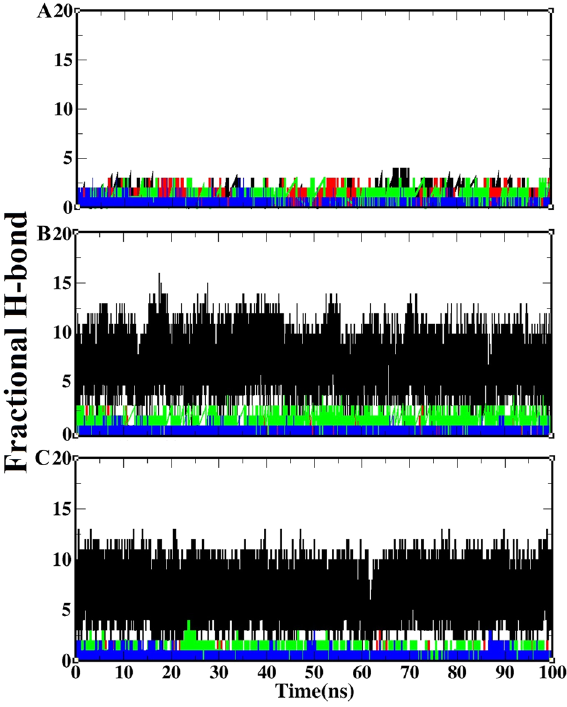
Figure 2. The fractional H-bonds of the receptor-spike protein complex during the simulation: hydrogen bonds between four regions of the ACE2 receptor (19–33, 35–54, 325–331, and 334–339) and receptor-binding motif in SARS-CoV ( A ), chimeric structure ( B ) and SARS-CoV-2 ( C ). Black, red, green and blue lines in each graph are related to residues 19–33, 35–54, 353–358 and 325–331 of the ACE2 receptor, respectively. The fractional H-bond graphs have been plotted using xmgrace from Grace plotting tool (https:// plasma- gate. weizm ann. ac. il/